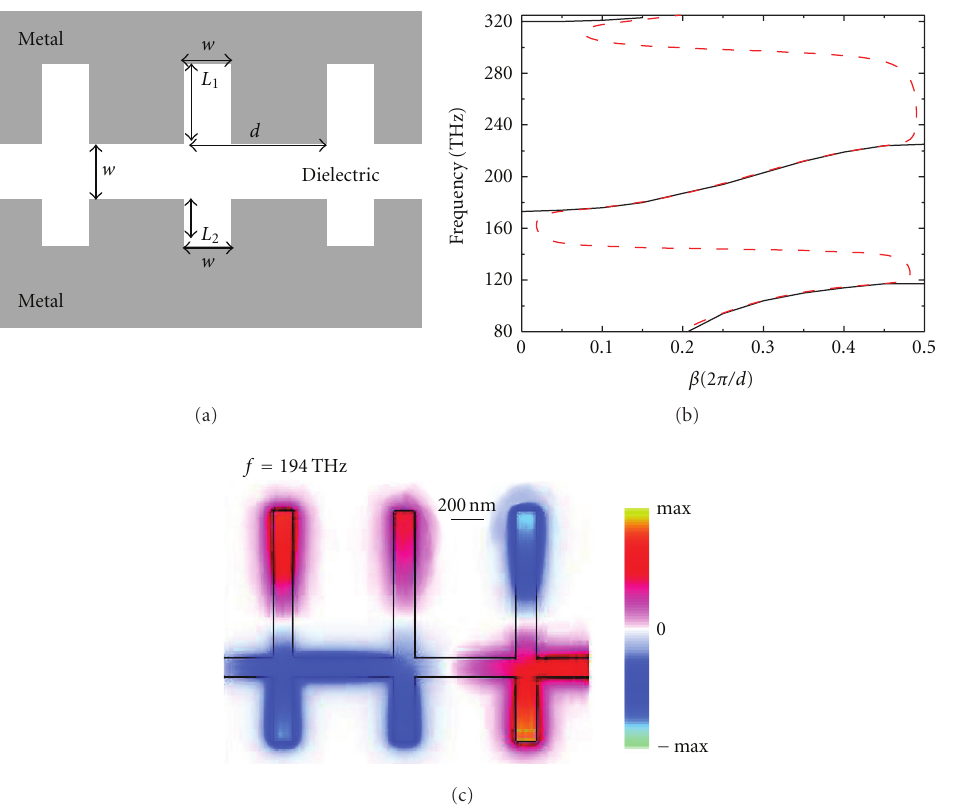
Figure 3: (a) Schematic of a plasmonic waveguide system consisting of a periodic array of two MDM stub resonators side-coupled to a MDM waveguide. (b) Dispersion relation of the plasmonic waveguide system of Figure 2(a) calculated using FDFD (red dashed line). Results are shown for a silver-air structure with d = 300 nm, L 1 = 360nm, L 2 = 160 nm, and w = 50nm. Also shown is the dispersion relation for lossless metal (black solid line). (c) Magnetic field profile for the structure of (a) for L 1 = 360nm, L 2 = 160 nm, w = 50nm at f =